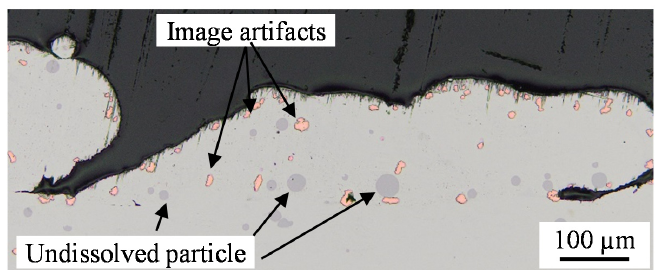
Figure 8. Pre-melted layer with low VED/laser beam intensity parameters set (500 µ m spot diameter, 100 W laser power, 600 mm/s scan speed, 250 µ m hatch, Ta 45).